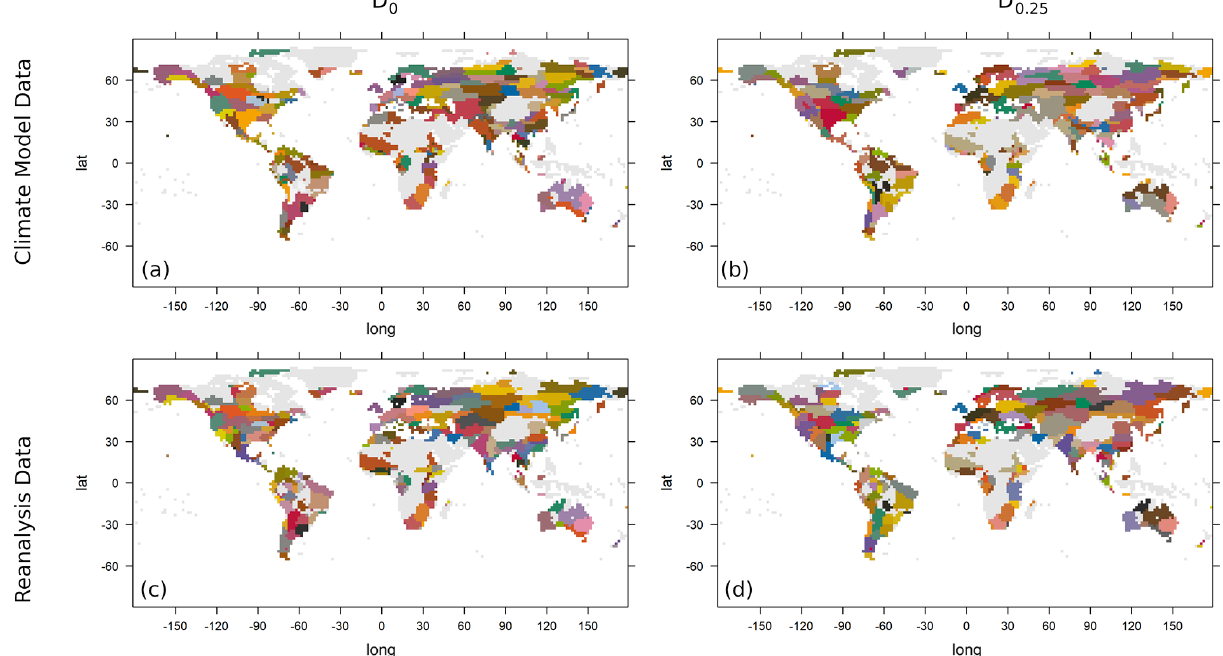
Figure 7. Clustering of AWI-ESM model data (a, b) and observational data (c, d) with the dissimilarity measure D 0 and threshold h = 0 . 825 (a, c) and with the dissimilarity measure D 0 . 25 and threshold h = 0 . 65 (b, d)